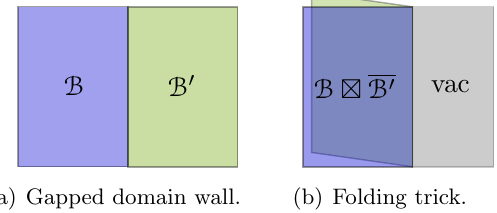
Figure 2 . (a) A bTO B and a B ′ connected by a GDW via condensing some bosons in B . Via the folding trick along the GDW, this picture is equivalent to (b) A bTO B ⊠ B ′ sharing a gapped boundary with the